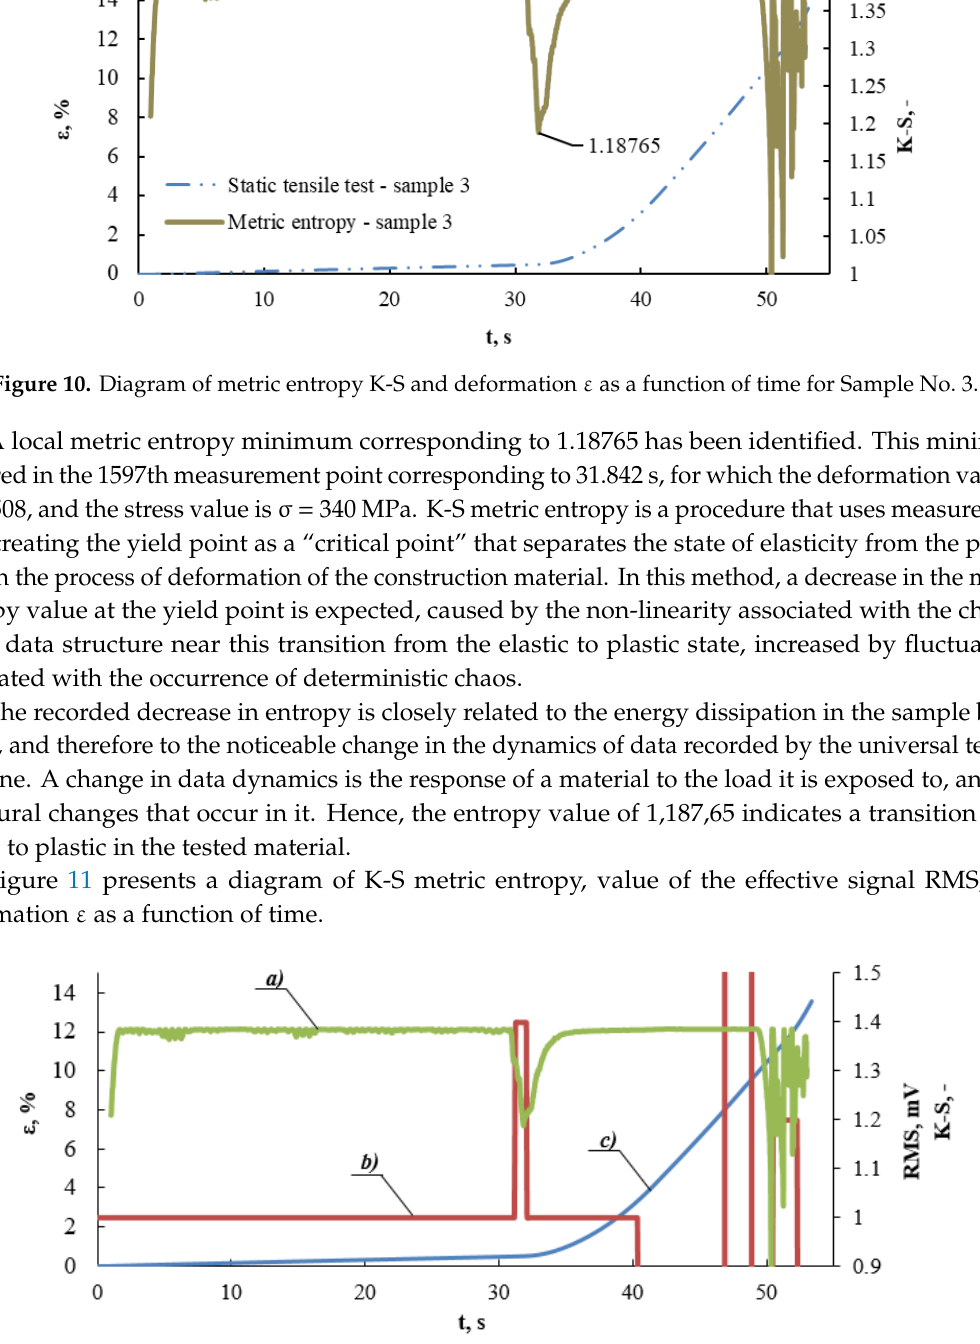
Figure 11. Diagram of ( a ) metric entropy K-S, ( b ) value of effective electrical signal RMS, ( c ) deformation ε as a function of time.